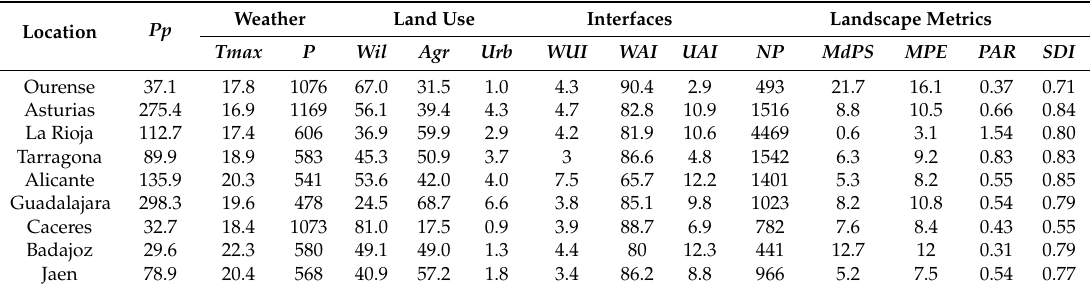
Pp : Population density (inhab/km 2 ); Tmax : Annual maximum temperature (°C); P : Annual precipitation (mm); Wil : Forest, shrubs and pastures (%); Agr : Croplands (%); Urb : Urban (%); WUI :